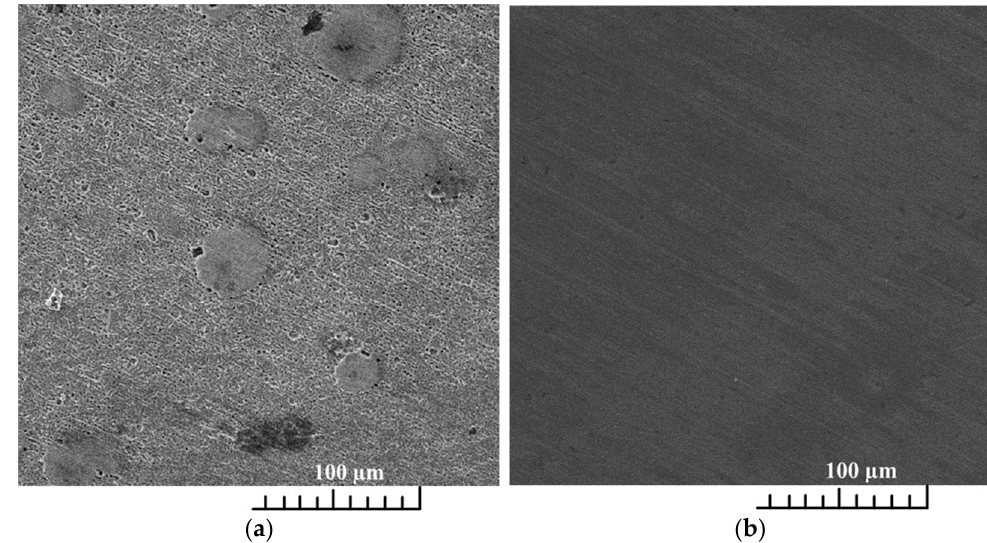
Figure 11. SEM scan of the carbon ‐ steel sample after 4 h in the simulated brine saturated with CO 2 ( a ) without the extract and ( b ) with 12 mL/L of the extract (Adapted from [24]).